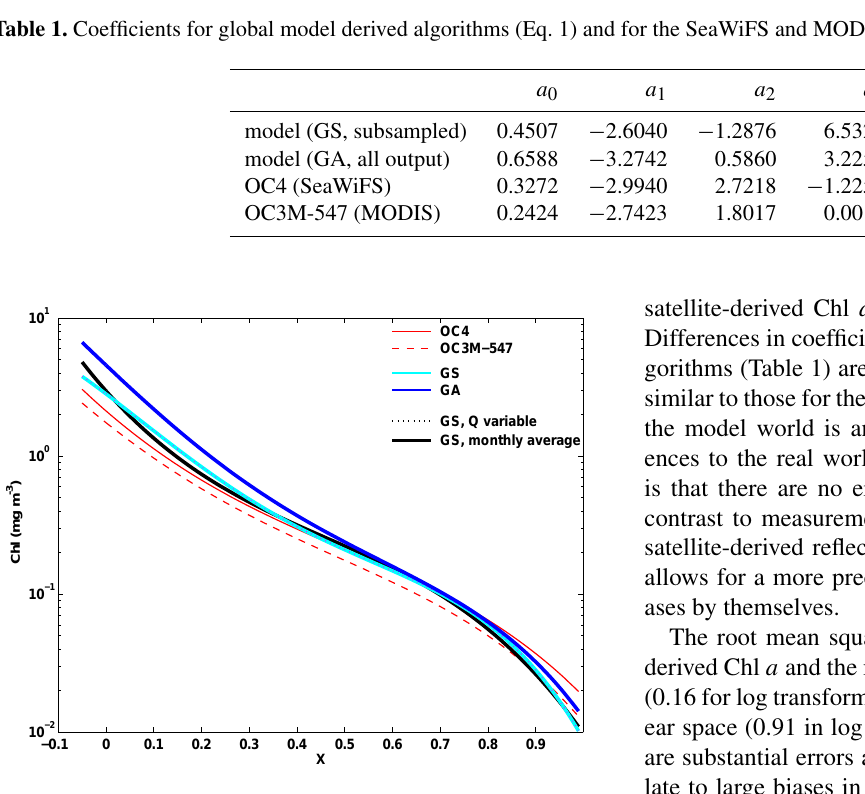
Figure 4. Polynomials for the Chl a algorithm using the blue/green reflectance ratio. Shown are two real-world algorithms: NASA OC4 (red solid, used in SeaWiFS and OC-CCI products) and NASA OC3M-547 (red dashed, used for MODIS product). Model algo- rithms shown are GS (light blue, same as in Fig. 3a), where coef- ficients are found from a subset of model output as dictated from real-world in situ observations and GA (dark blue, same as dashed line in Fig. 3b) where coefficients are found using the full dataset. Also shown are two additional polynomials discussed in the Ap- pendix: one found using a variable bi-directional coefficient, Q , and a subsampling of output as in GS (dotted black line almost exactly on top of the light blue line), and another where coefficients were found from a subsampling as in GS but using monthly average re- flectance and Chl a (black line). Note that the algorithms for the model come from band ratios of the largest of R RS at 450, 475, 500nm to R RS at 550nm. For the real-world algorithms, the band ratios are different and specific for the satellite sensor (SeaWifs or